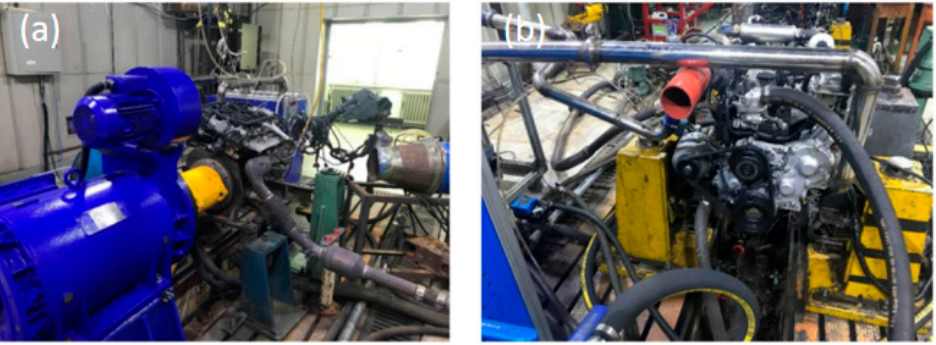
Figure 2. Engine bench test device diagram. ( a ) Engine’s testing bench. ( b ) The CA4D28C5 diesel engine testing device.